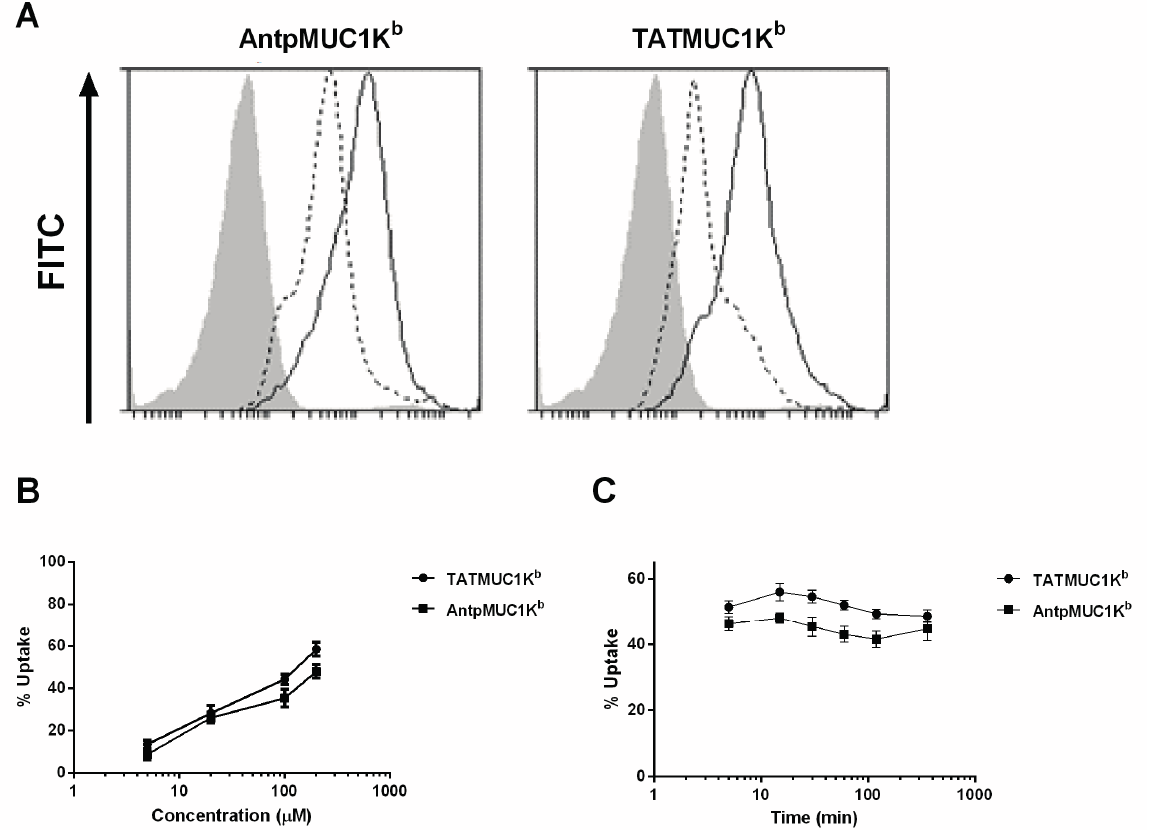
Figure 5. Uptake of AntpMUC1K b and TATMUC1K b peptides by DC in vitro . ( A ) AntpMUC1K b and TATMUC1K b staining by BC2 antibody after pulsing at 100 µM for 60 min with uptake assessed as the difference between surface (dotted line) and intracellular (bold line) staining by flow cytometry. Isotype controls are shown as filled grey areas. DC were pulsed with AntpMUC1K b or TATMUC1K b peptides at either varying concentrations (5 to 200 µM) for 60 min ( B ) or a constant dose of 100 µM for set times between 5 and 360 min ( C ). Uptake was determined by flow cytometry as the percent surface staining subtracted from the percent intracellular staining (mean ± SEM, for 3